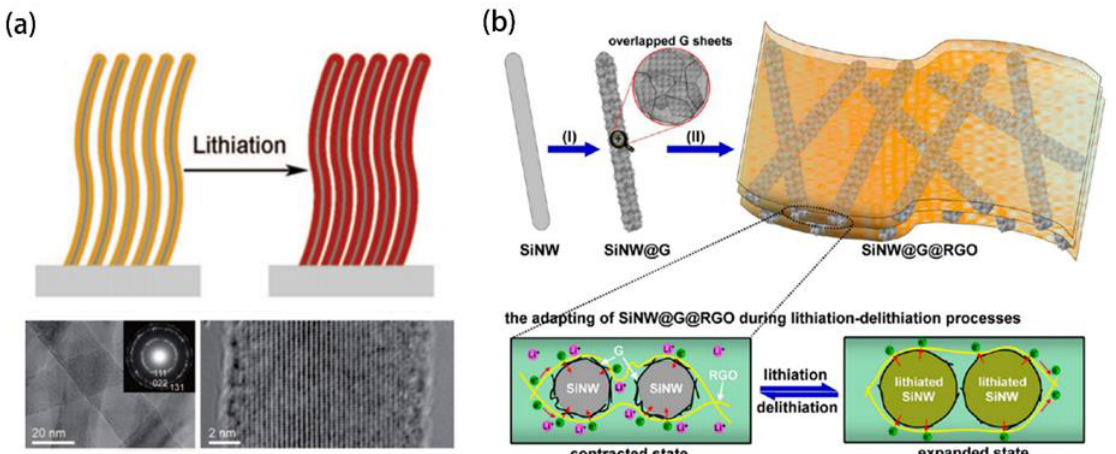
Figure 4. ( a ) Schematic diagram of working principle and TEM images of SiNWs [22]. ( b ) Schematic diagram of synthesis method and working principle of SiNW@G@RGO anode for LIBs [24]. Reprinted with permission from [22]. Copyright 2009 American Chemical Society. Reprinted with permission from [24]. Copyright 2013 American Chemical Society.